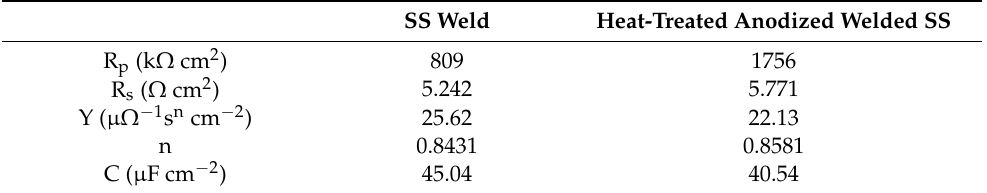
Figure 7. Niquist impedance diagram ( a ), Bode plot ( b ) for welded SS and heat-treated anodized welded SS, and equivalent circuit used for fitting ( c ). Table 3. Electrochemical impedance spectroscopy (EIS) parameters with Randles circuit coupled with constant phase element